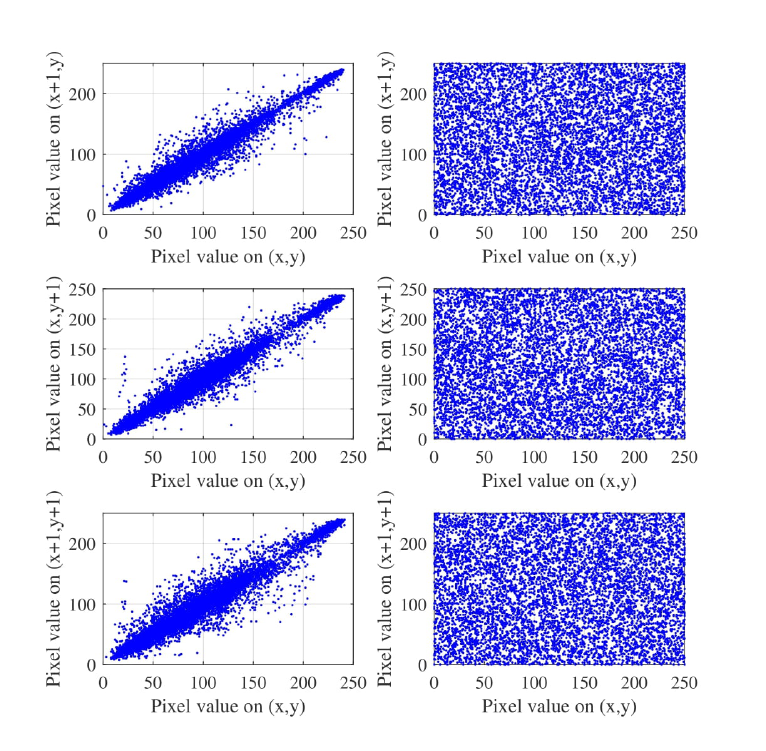
Figure 17. Distribution of adjacent pixels in the plain and encrypted images of Goldhill in the three directions: horizontal, vertical, and diagonal, respectively.